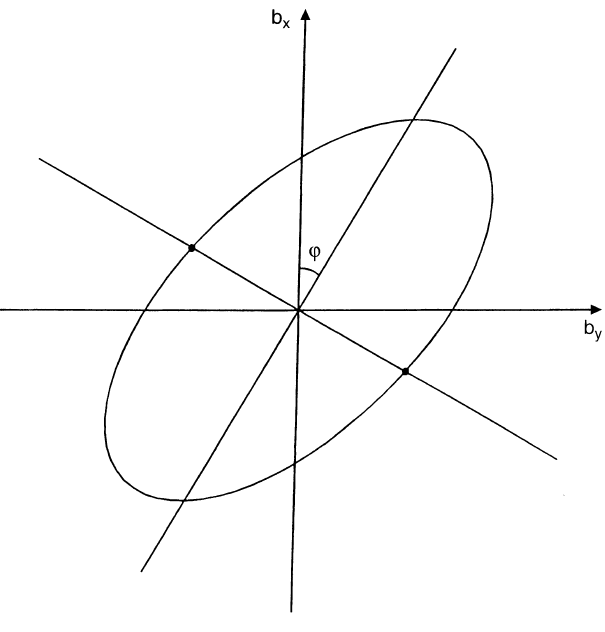
Fig. 2. The hodograph of vector-function b t (cid:136) (cid:115) (cid:133) t (cid:134) : The two points in the hodograph correspond to the moments at which b z (cid:133) t (cid:134)